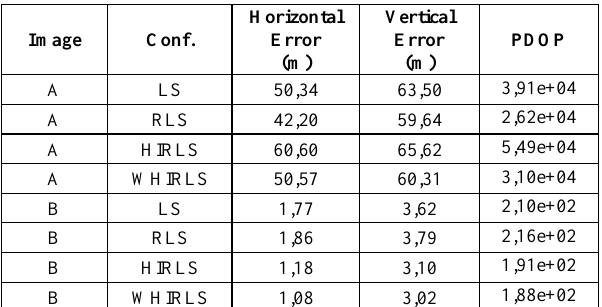
Table 3. Camera Position Error